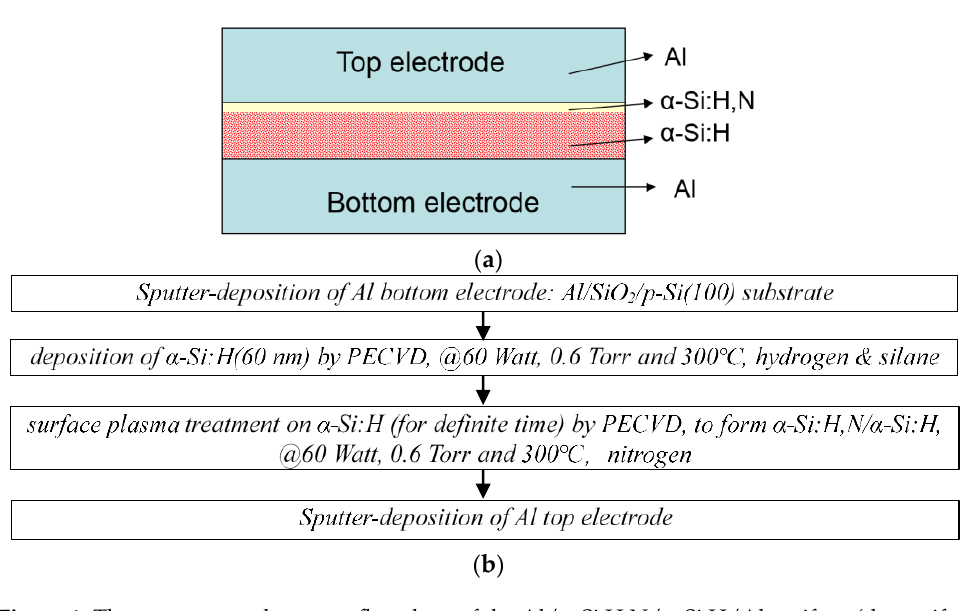
Figure 1. The structure and process-flowchart of the Al/ α -Si:H,N/ α -Si:H/Al antifuse (the antifuse area is 314 μm 2 ): ( a ) schematic cross-section, ( b ) process flowchart.